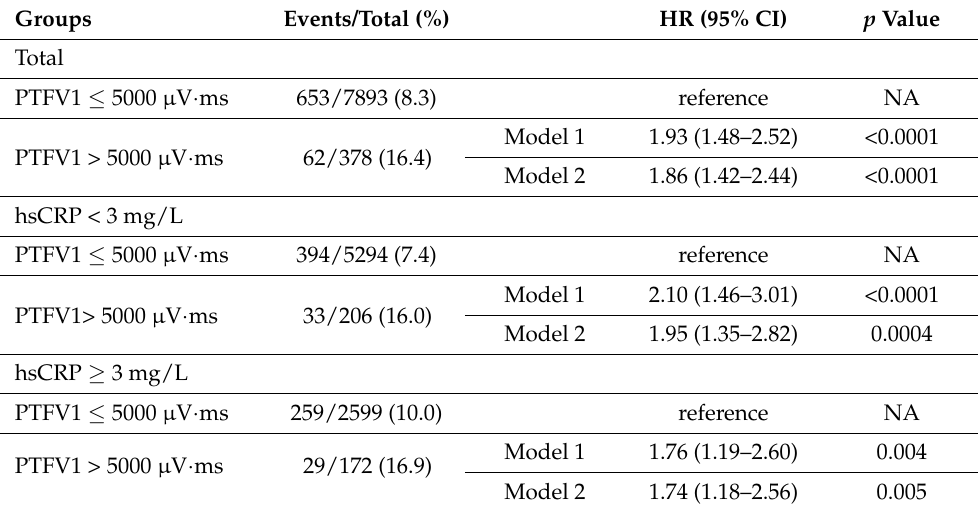
Table 3. Associations of PTFV1 with ischemic stroke recurrence within 1 year according to hsCRP threshold.